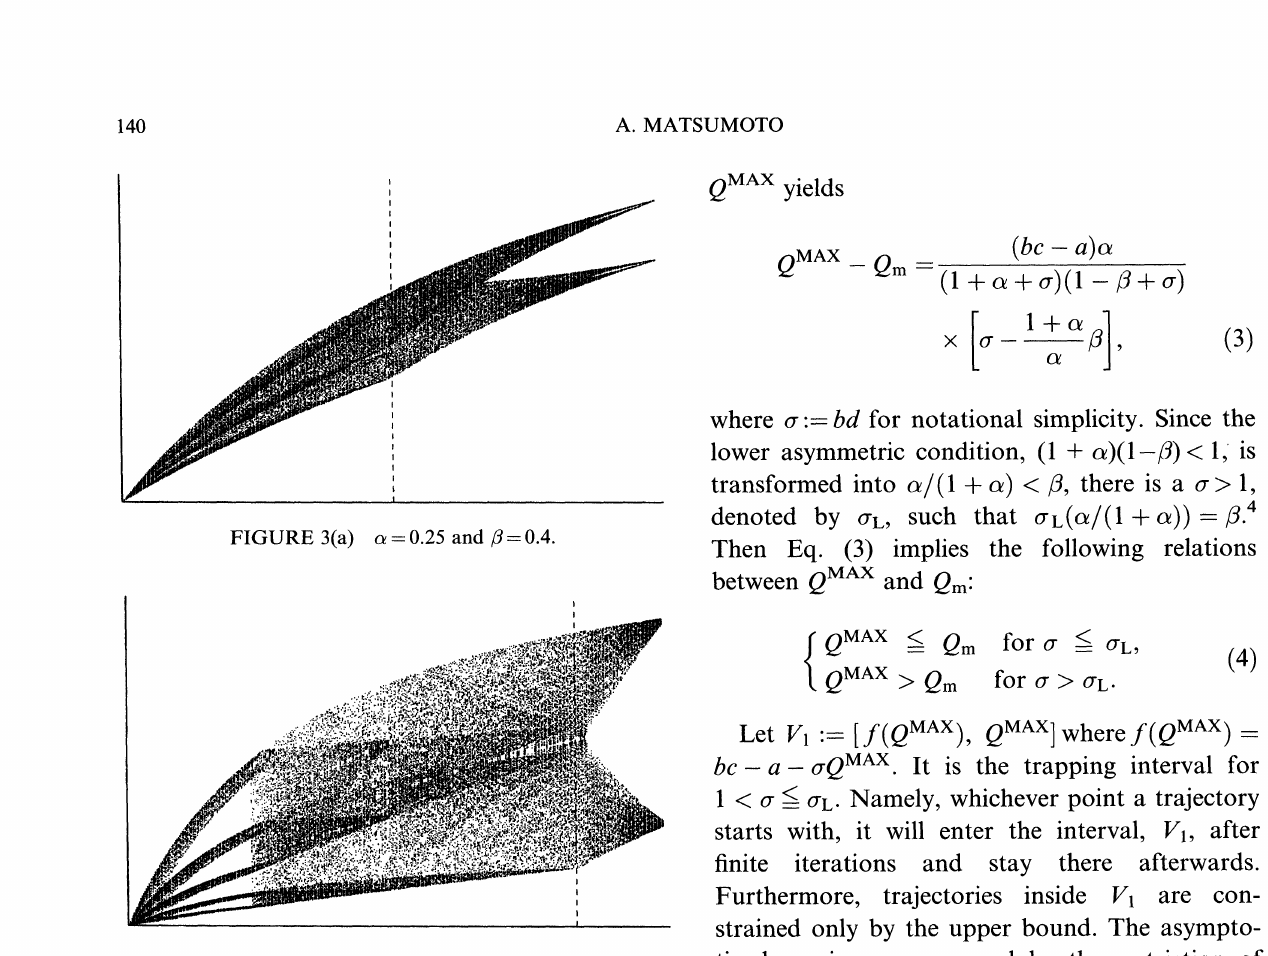
FIGURE 3 a=2 and /3=0.8. Bifurcation diagrams in the lower asymmetric